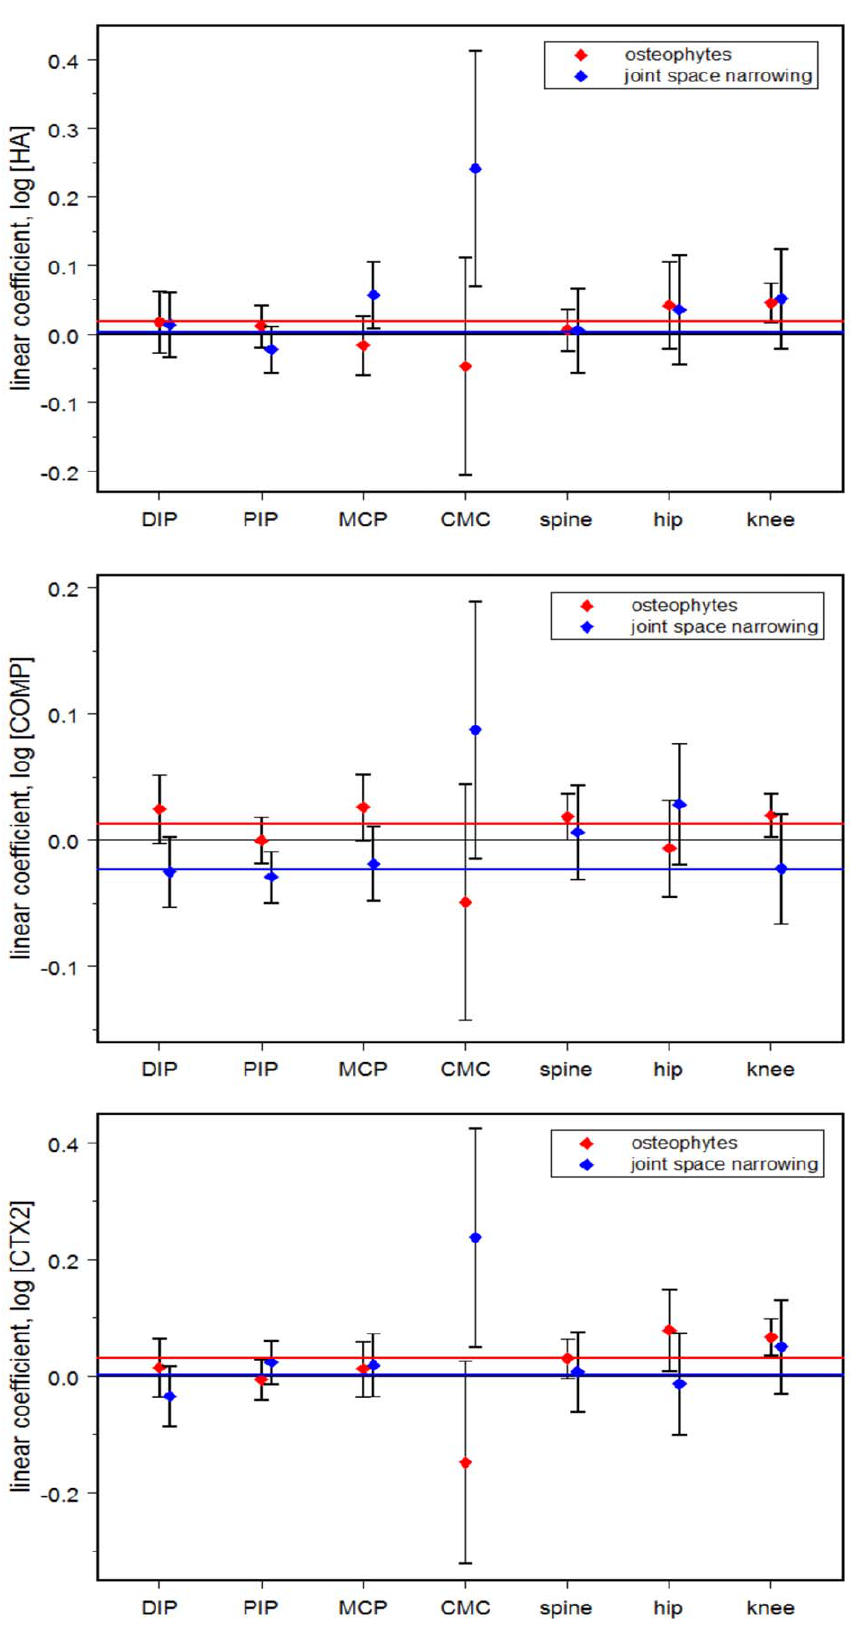
Figure 3. Plot of linear coefficients of biomarker concentrations and radiographic features of OA for 7 joint systems (adjusted). The linear coefficient was derived for the association of each biomarker with OST and JSN for each joint site. The mean linear coefficient from all joint sites